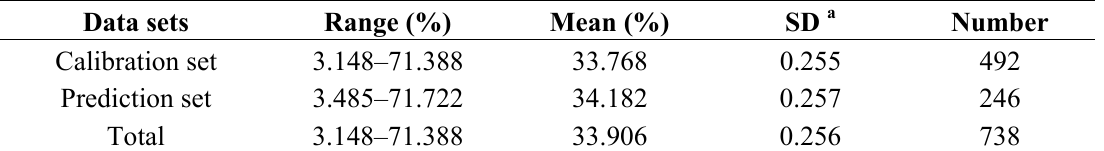
Table 5. Statistical information of moisture content (w.b., %) of samples in three data sets.